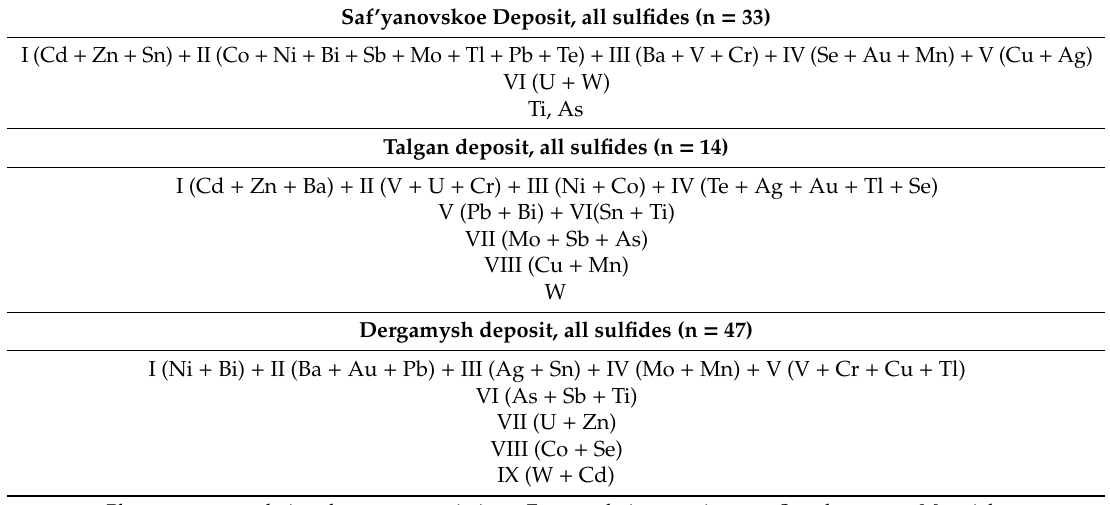
Table 3. Trace element associations in pyrite nodules of the Saf’yanovskoe, Talgan, and Dergamysh deposits. Saf’yanovskoe Deposit, all sulfides (n =